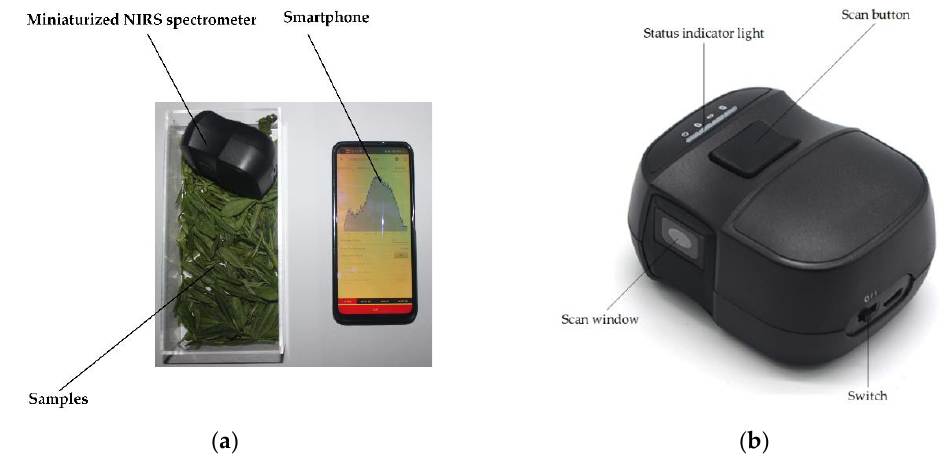
Figure 2. Miniaturized NIRS system, ( a ) spectrum acquisition process, and ( b ) miniaturized NIRS spectrometer [25]. For spectrum acquisition, the scan window of the miniaturized NIRS spectrometer is placed close to the samples and the scan button is then pressed, and the acquired spectrum is displayed on the smartphone.